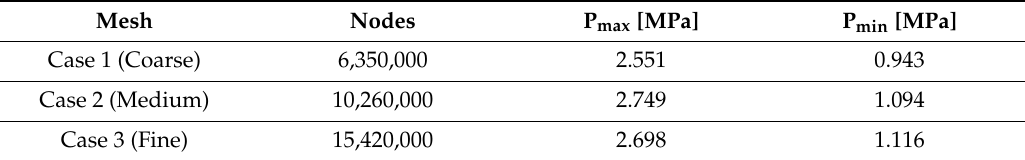
Table 2. Results of the mesh independence study for self-excited oscillation pulsed jet (SEOPJ) ( L / d 1 = 4, D / d 1 = 8, P i = 2.0 MPa).